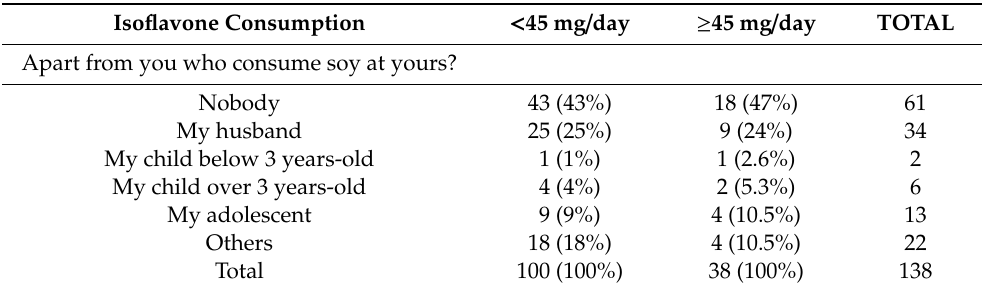
Table 5. Repartition of consumers that have isoflavone intake below and over 45mg / day. Isoflavone Consumption < 45 mg / day ≥ 45 mg / day TOTAL Apart from you who consume soy at yours? Nobody 43 (43%) 18 (47%) 61 My husband 25 (25%) 9 (24%) 34 My child below 3 years-old 1 (1%) 1 (2.6%) My child over 3